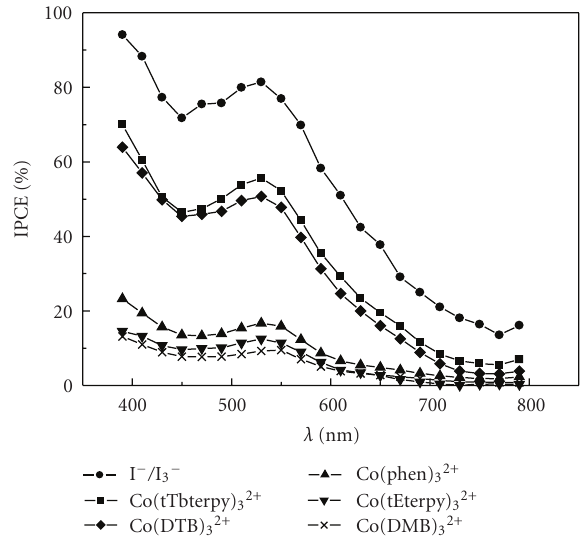
Figure 9: Photoaction spectra of N3 bound to nanocrystalline TiO 2 films in the presence of di ff erent electron mediators in MPN solu- tions: 0.25M LiI/25mM I 2 (circles), 0.25M Co(tTBterpy) 2+ / 25mM 2 NOBF 4 (squares), 0.25 M Co(DTB) 2+ / 25mM NOBF 4 (diamonds), 3 0.25M Co(phen) 2+ 3 / 25mM NOBF 4 (triangles), 0.25 M Co(tEt- erpy) 2+ 2 / 25mM NOBF 4 (upside down triangles), and saturated ( < 0.15M) Co(DMB) 2+ / 25mM NOBF 4 (crosses). 0.25M LiClO 4 3 was added to all solutions containing a cobalt